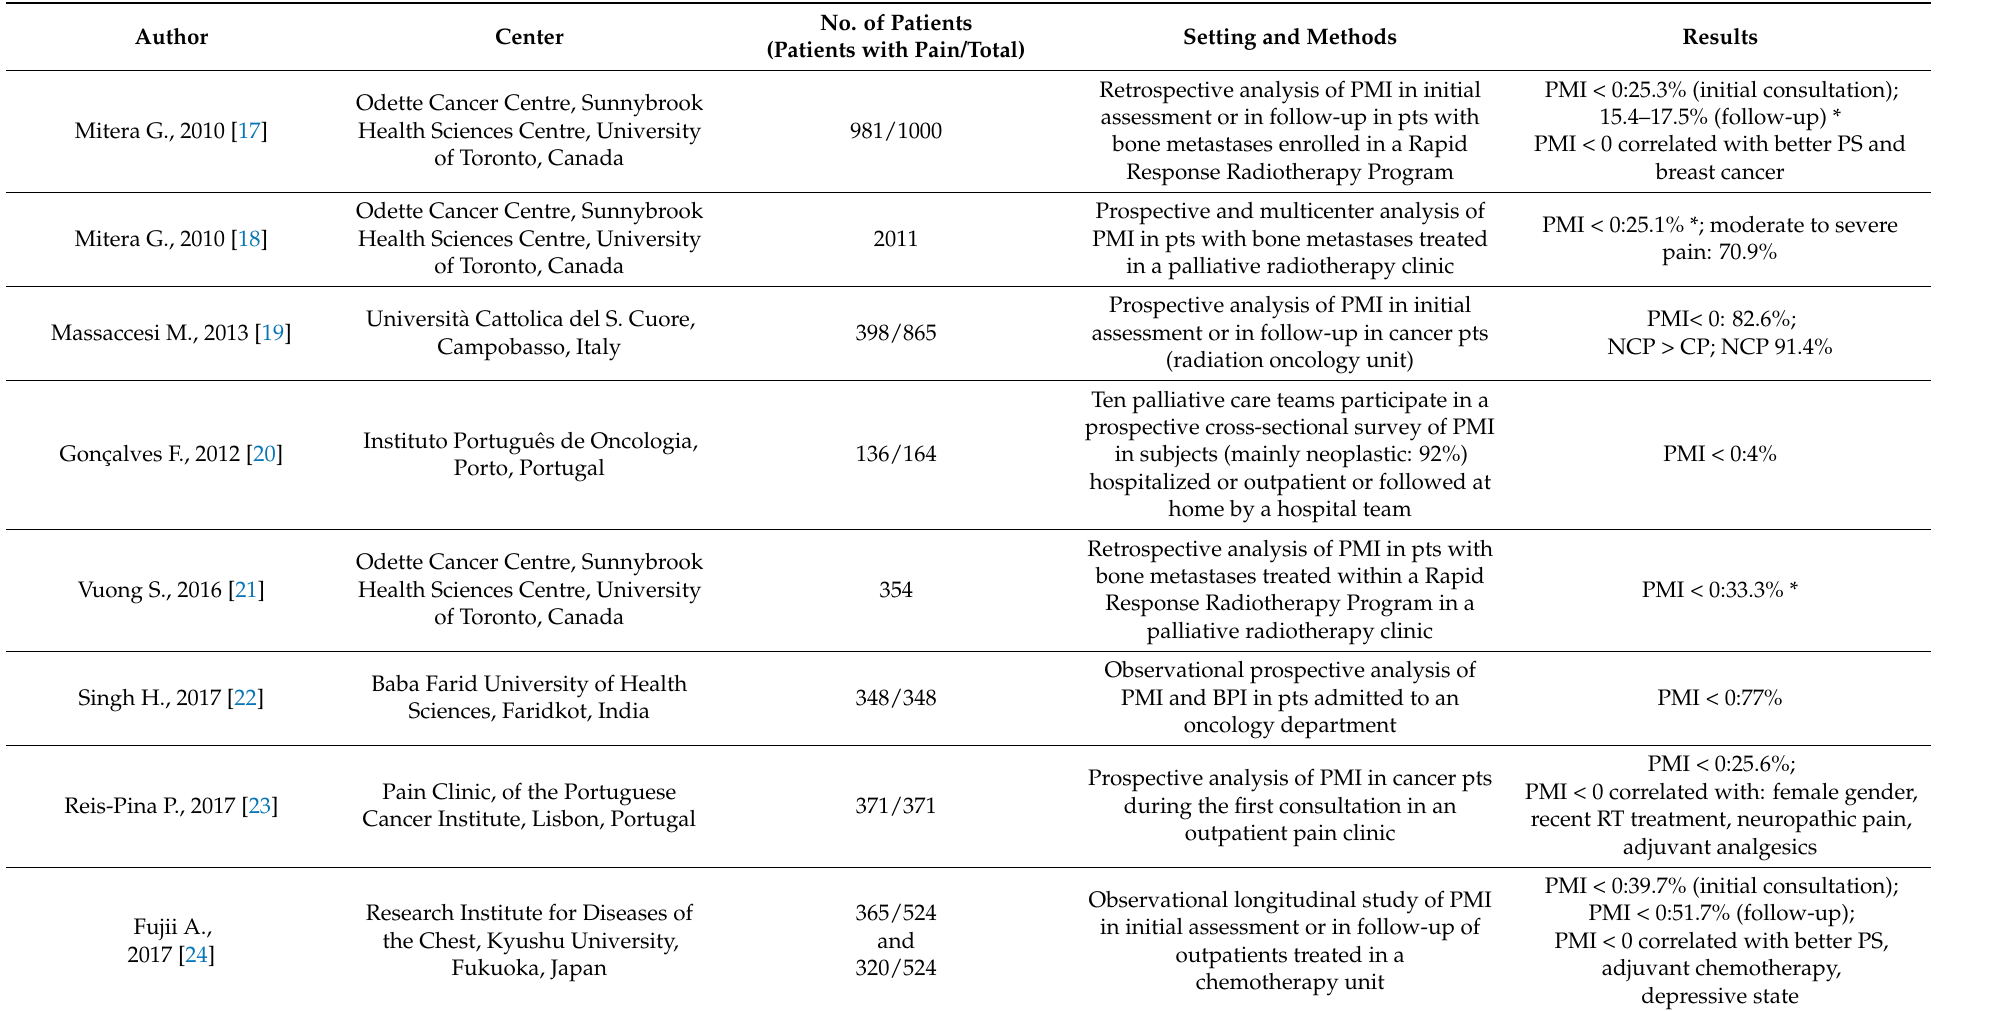
Table 4. Comparison with other studies on Pain Management Index evaluated in cancer